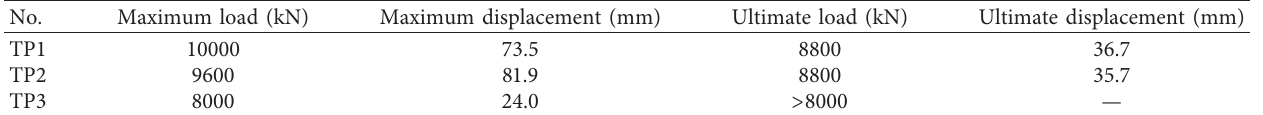
Table 2: Summary of pile test results.